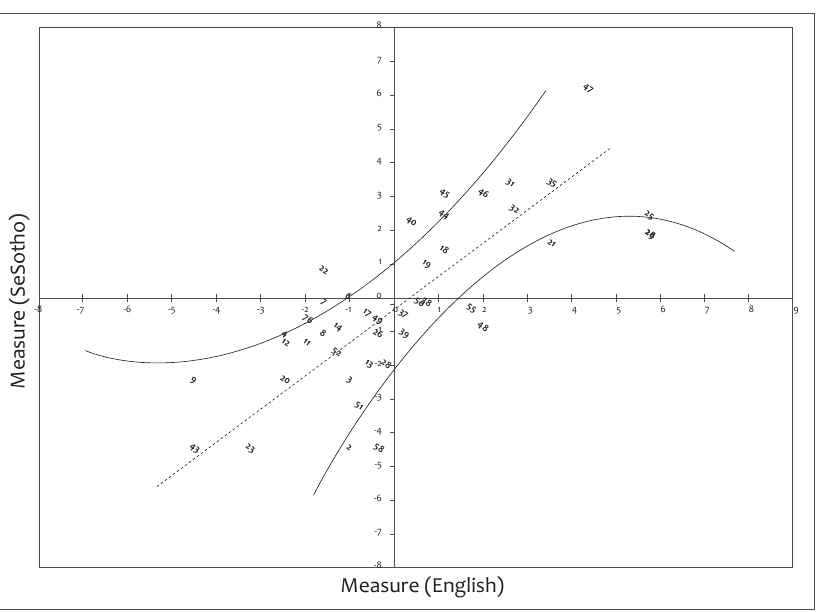
Figure 4: English-Sesotho comparison Figure 3 indicates the extent to which the English and Sesotho cohorts varied in their responses to the items used to measure the latent